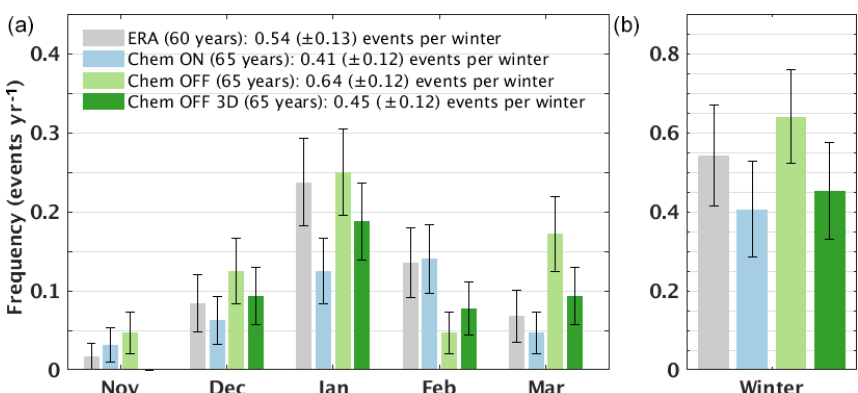
Figure 7. Monthly SSW frequency (a) and winter SSW frequency (b) for the combined ERA data (gray), Chem ON (blue), Chem OFF (light green), and Chem OFF 3D (dark green). Error bars are shown in the figure. They indicate the standard error for the monthly frequencies and the 95% confidence interval based on the standard error for the mean winter